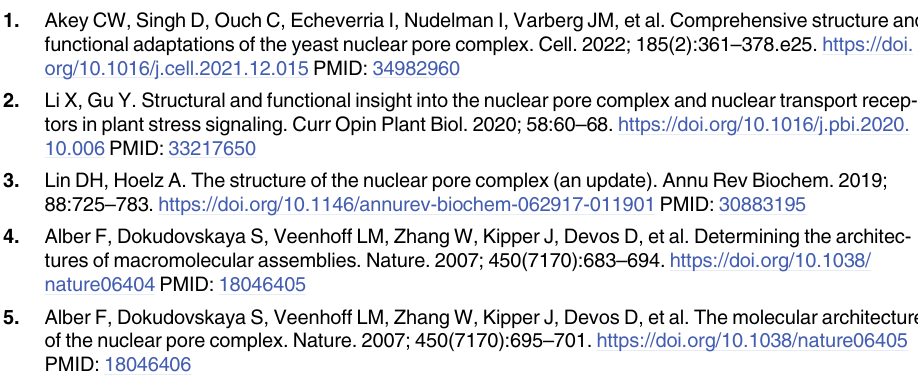
S5 Data. All numerical values that underline chart summary data in figures. (XLSX) S1 Raw Images. Raw